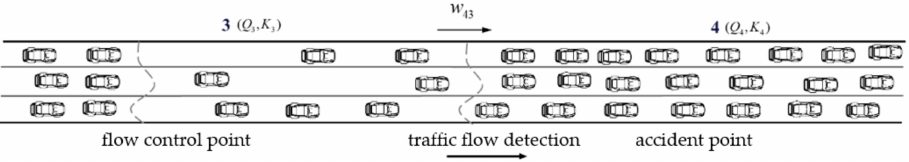
Figure 11. Diagram of traffic flow when the queue